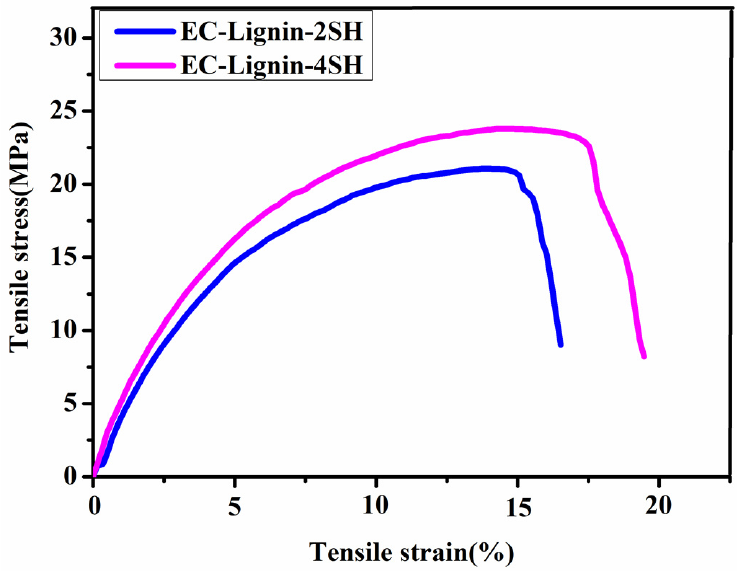
Figure 16. Tensile stress and strain of the EC–lignin cross − linked polymers. The C gel of the cross − linked polymers were detected and the results are shown in Ta- ble 3. The results show that C gel is positively correlated to the tensile stress for the same Polymer type of polymers. For the EC − n − 2SH cross − linked polymers, when the tensile stress in- creased from 16.41 MPa to 23.59 MPa, the C gel increased from 94.9% to 98.0%. The other cross − linked polymers showed the same relationship between the gel content and the ten- sile strength. Table 3. Tensile stress, tensile strain and C gel of the cross − linked polymers.